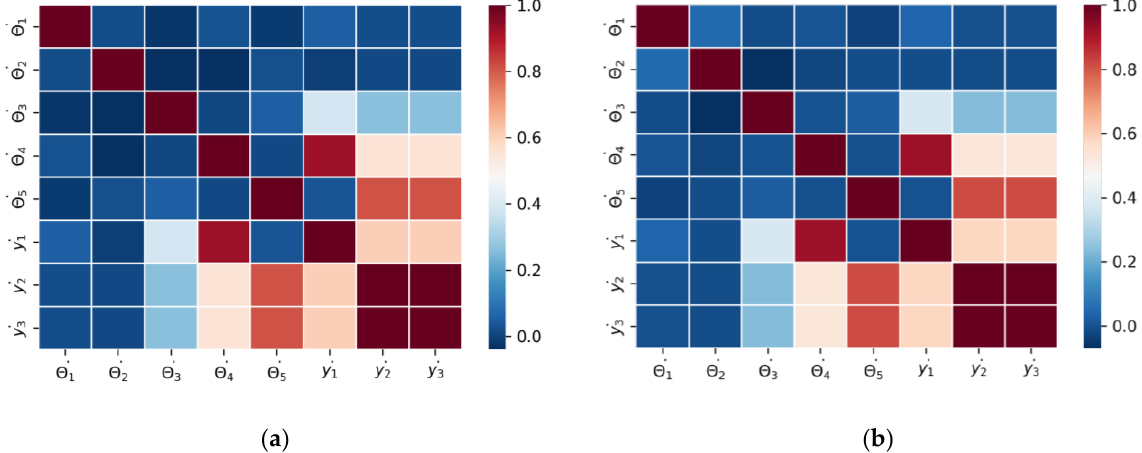
Figure 7. Pearson ’ s coefficients heat map correlations for the systems that use sodium cyanide as the leaching agent without Hg removal ( a ) and with Hg removal ( b ).